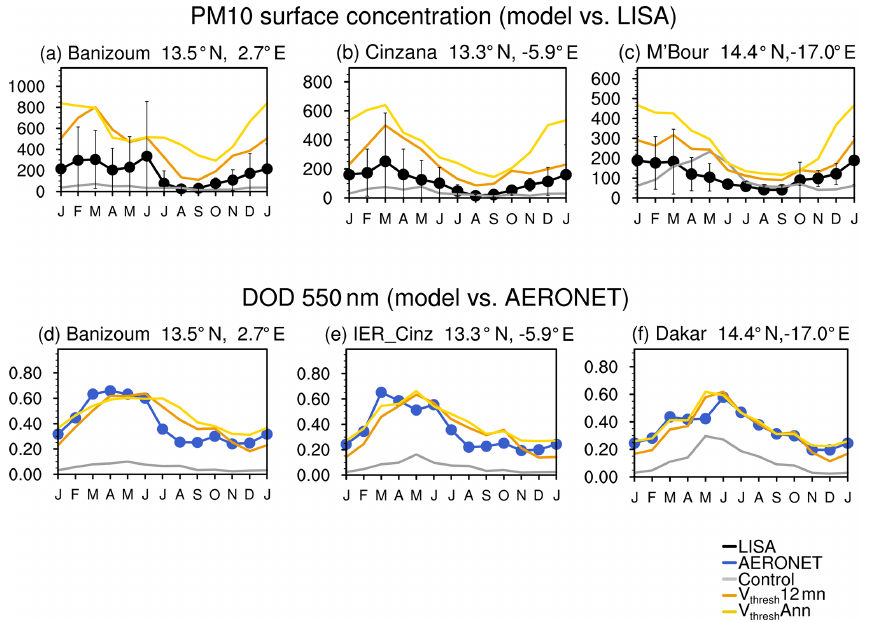
Figure 13. (a–c) Seasonal cycle of PM 10 surface concentration (black) over three sites from the LISA project, along with PM 10 surface dust concentration from the Control (grey), V thresh 12mn (orange), and V thresh Ann (yellow) simulations. Error bars are ± 1 standard deviation of the daily mean in each month averaged over 2006–2014 (units: µgm − 3 ). (d–f) Seasonal cycle of DOD (550nm) from three AERONET sites co-located with LISA sites (blue) versus that modeled by the Control (grey), V thresh 12mn (orange), and V thresh Ann (yellow)